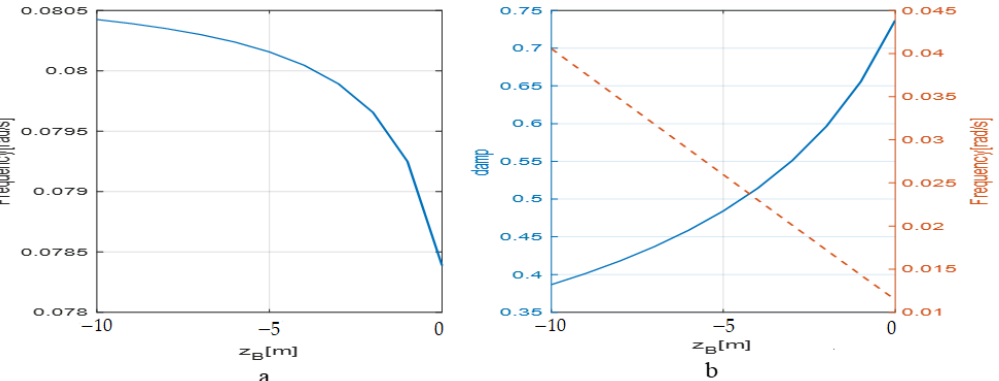
Figure 12. Curve of Influence of Vertical Buoyant Center Perturbation on Motion Mode of Pitching Channel: ( a ) frequency characteristic curve of the first-order inertia damping mode of the pitching channel affected by the vertical perturbation of the buoyant center, ( b ) damping and frequency characteristic curves of the pendulum motion mode of the pitching channel affected by the vertical perturbation of the buoyant center